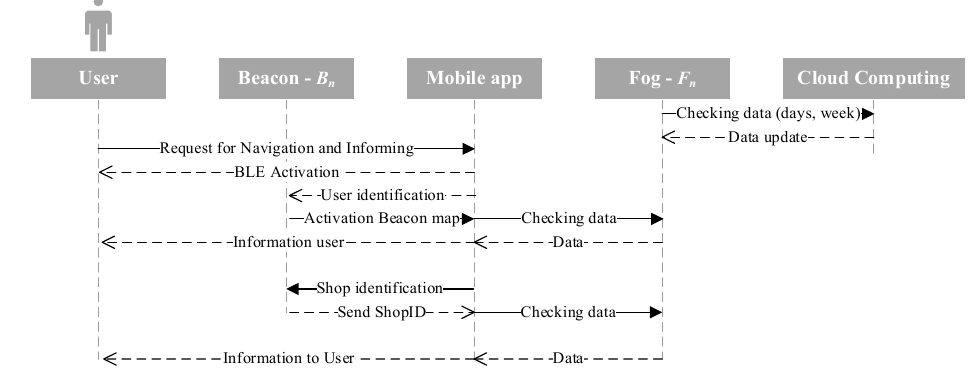
Figure 3. Process of objects identification and informing